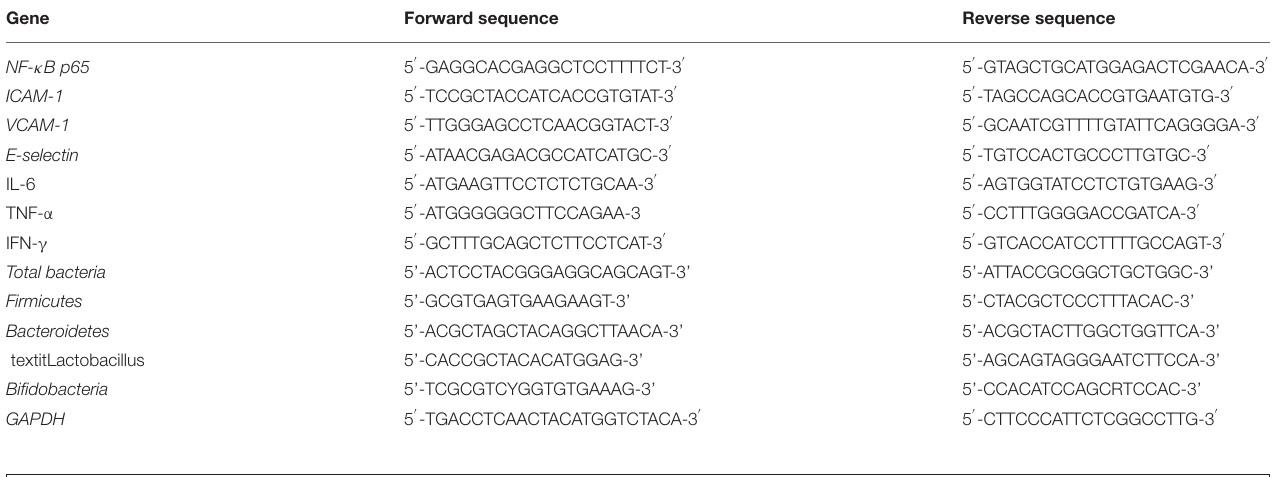
TABLE 1 | Primer sequences in this experiment.